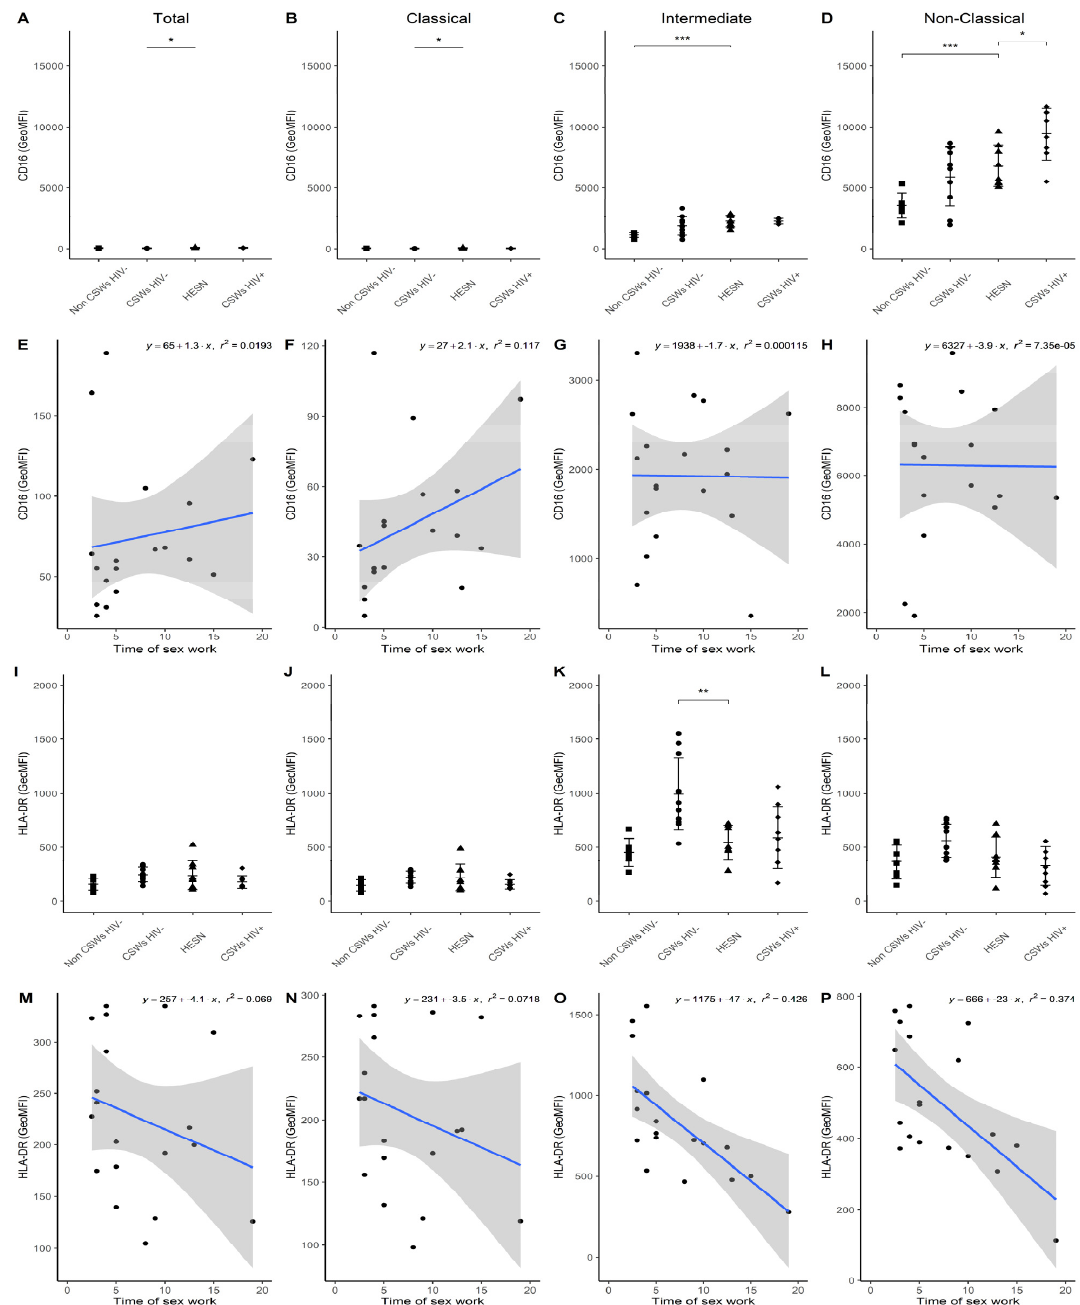
Figure 3. Flow cytometry analyses of CD16 and HLA-DR expression levels by live blood mono- cyte populations. ( A – D ) Levels of expression of CD16 and ( I – L ) HLA-DR proteins, as determined by geometric mean fluorescence intensity (GeoMFI), by ( A , I ) CD14 + total, ( B , J ) CD14 + CD16 - classical, ( C , K ) CD14 + CD16 + intermediate, and ( D , L ) CD14 low/dim CD16 ++ non-classical monocytes. Data are pre- sented as the mean value ± SD of samples from 7 non-CSWs HIV- (HIV-1-uninfected control women from the general population), 9 CSWs HIV- (HIV-1-uninfected 2.5–5-year CSWs “early HESNs”), 11 HESNs (HIV-1-uninfected ≥ 10 years CSWs), and 9 CSWs HIV+ (HIV-1-infected CSWs). Significance levels are shown as * ( p < 0.05), ** ( p < 0.01), *** ( p < 0.001). ( E – H , M – P ) Linear regression analyses are shown for CSWs HIV- (HIV-1-uninfected 2.5–5-year CSWs “early HESNs”) and HESNs (HIV-1-uninfected ≥ 10 years